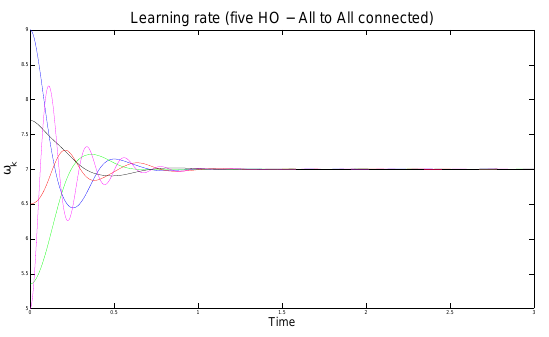
Fig. 2. Time evolution of the frequencies w k ( t ) for five Hopf oscillators with K 1 = 1, K 2 = 1 , K 3 = 5 , K 4 = 5, 2 4 w w w w K 1 1 ( 0 ) = 9, 2 ( 0 ) = 5 . 35, 3 ( 0 ) = 6 . 5, 4 ( 0 ) = 5, 5 = 3 w 5 ( 0 ) = 7 . 7 and with network topology “All to All”. The consensual frequency, given by Eq.(10), is w c =